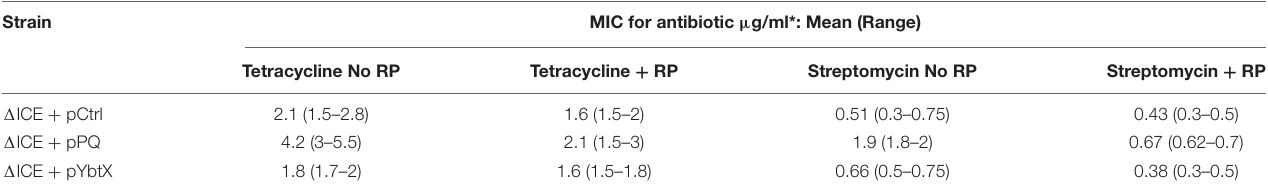
TABLE 2 | Minimum inhibitory concentrations (MIC) for K. pneumoniae mutant (cid:49) ICE containing control plasmid or plasmids encoding YbtPQ or YbtX in the presence or absence of reserpine (RP). Strain MIC for antibiotic µ g/ml*: Mean (Range) Tetracycline No RP Tetracycline + RP Streptomycin No RP Streptomycin + RP (cid:49) ICE +